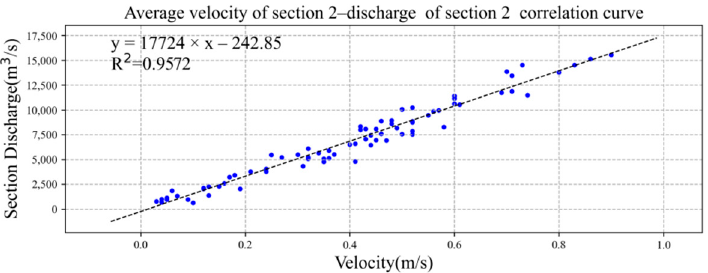
Figure 10. Linear correlation between average velocity of section 2 and total discharge of section. The data of blue dots represent the relationship between average velocity of section 2 (x) and total discharge of section 2 (y).